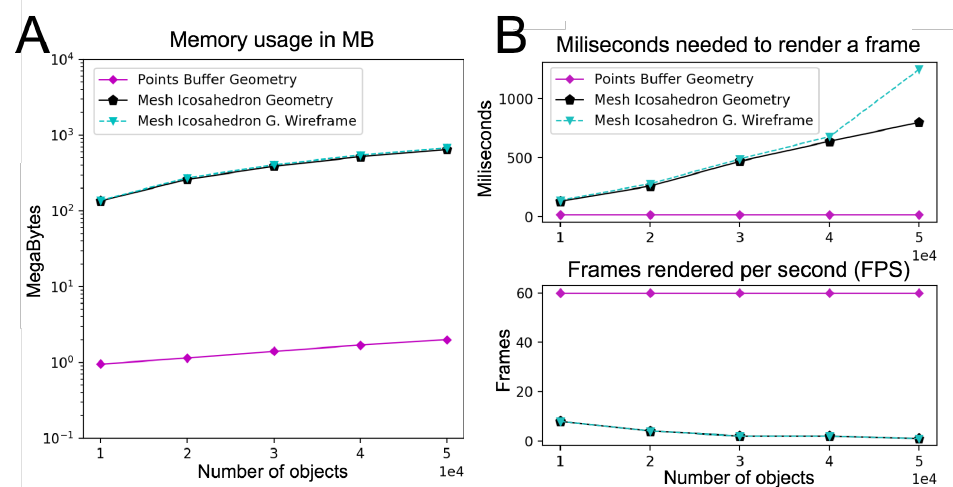
Figure 7. ( A ) Comparison of the memory usage using the Points Buffer and the two Mesh Icosahedrons Geometry objects. ( B ) Comparison of time used to render a frame and frames per second using the Points Buffer and the two Mesh Icosahedron Geometry objects.